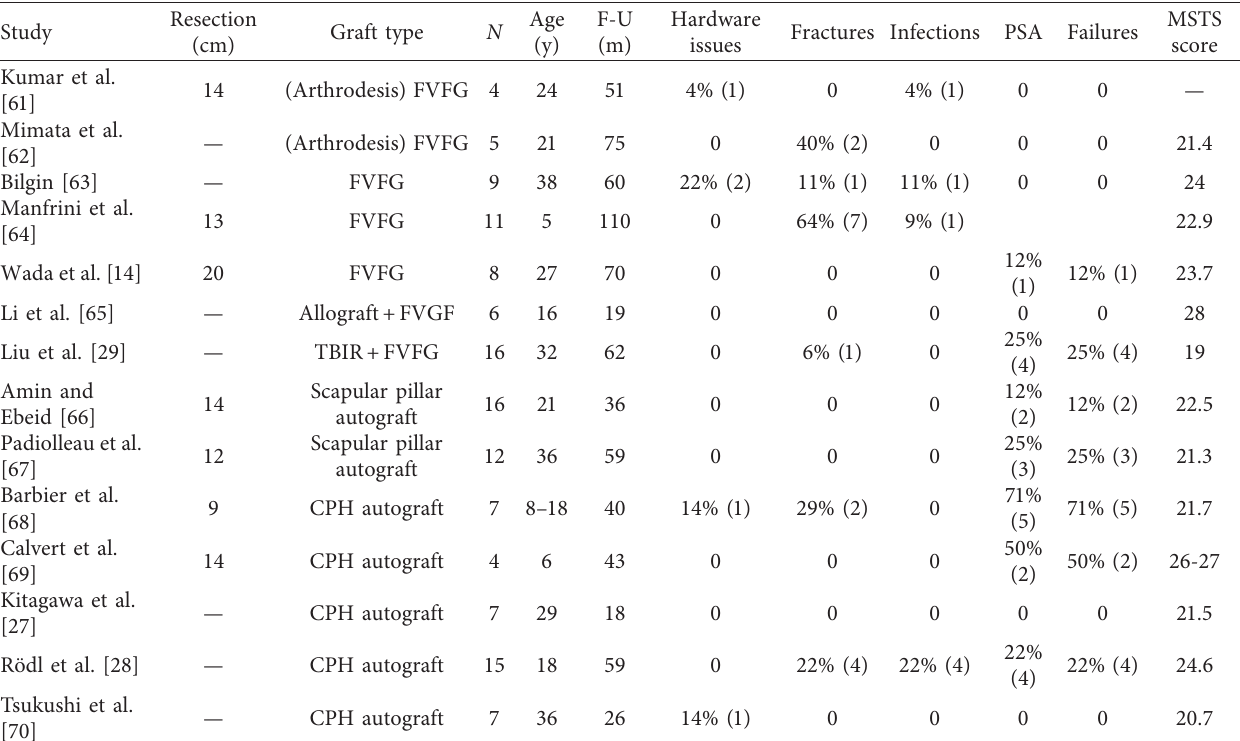
Table 2: Summary data for autograft